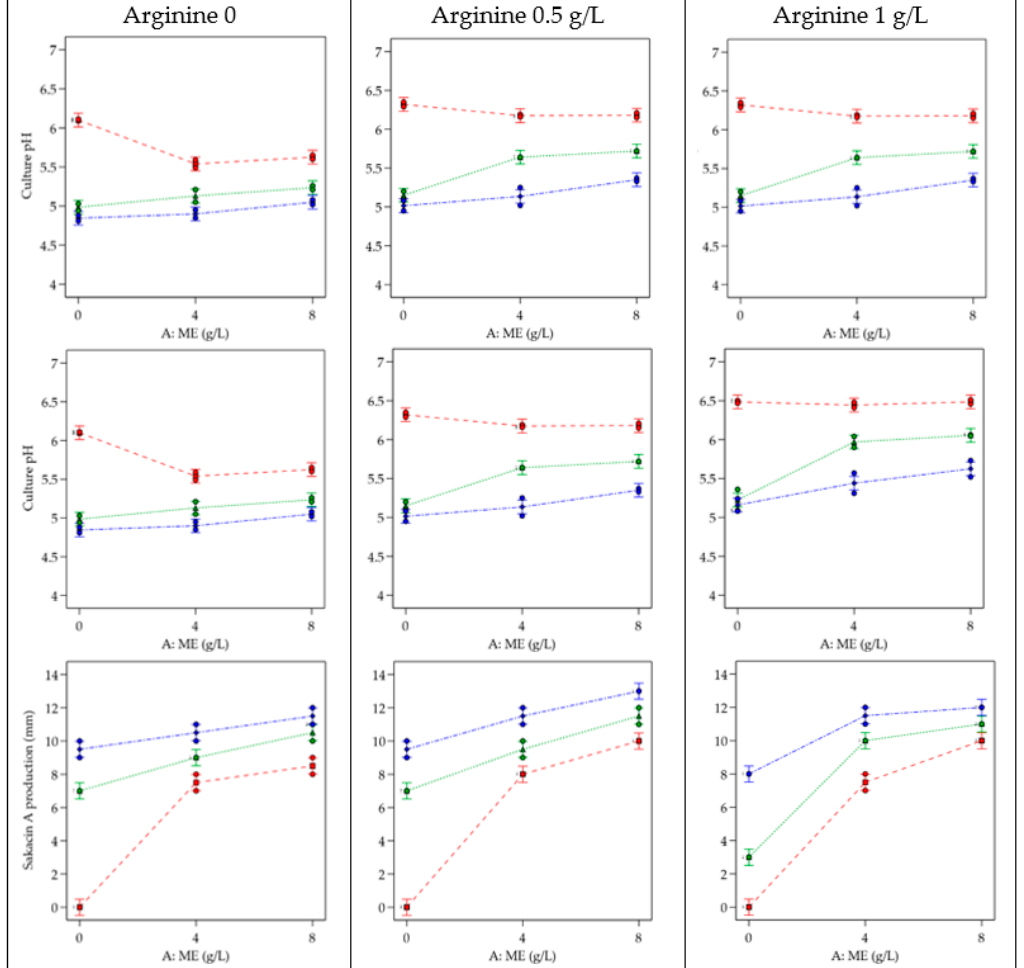
Figure 2. Interactions plots: responses related to culture pH (first row), lactic acid (second row) and sakacin A production (third row, expressed as inhibition halo vs. Listeria ) in supernatants of L. sakei . Factors: A-ME (Meat Extract) at 0-4-8 g/L on X-axis; B-YE (Yeast Extract) at 0 g/L (red)–4 g/L (green)– 8 g/L (blue); results obtained without arginine (first column), with arginine set at 0.5 g/L (second column) and 1 g/L (third column).